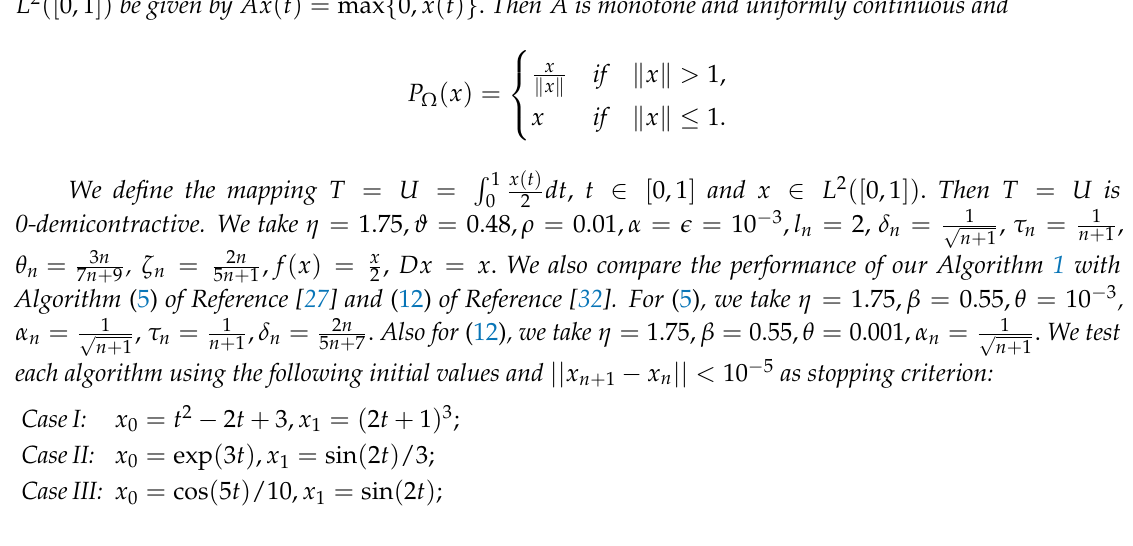
Figure 2. Example 2, Top Left: Case I; Top Right: Case II; Bottom Left: Case III; Bottom Right: Case